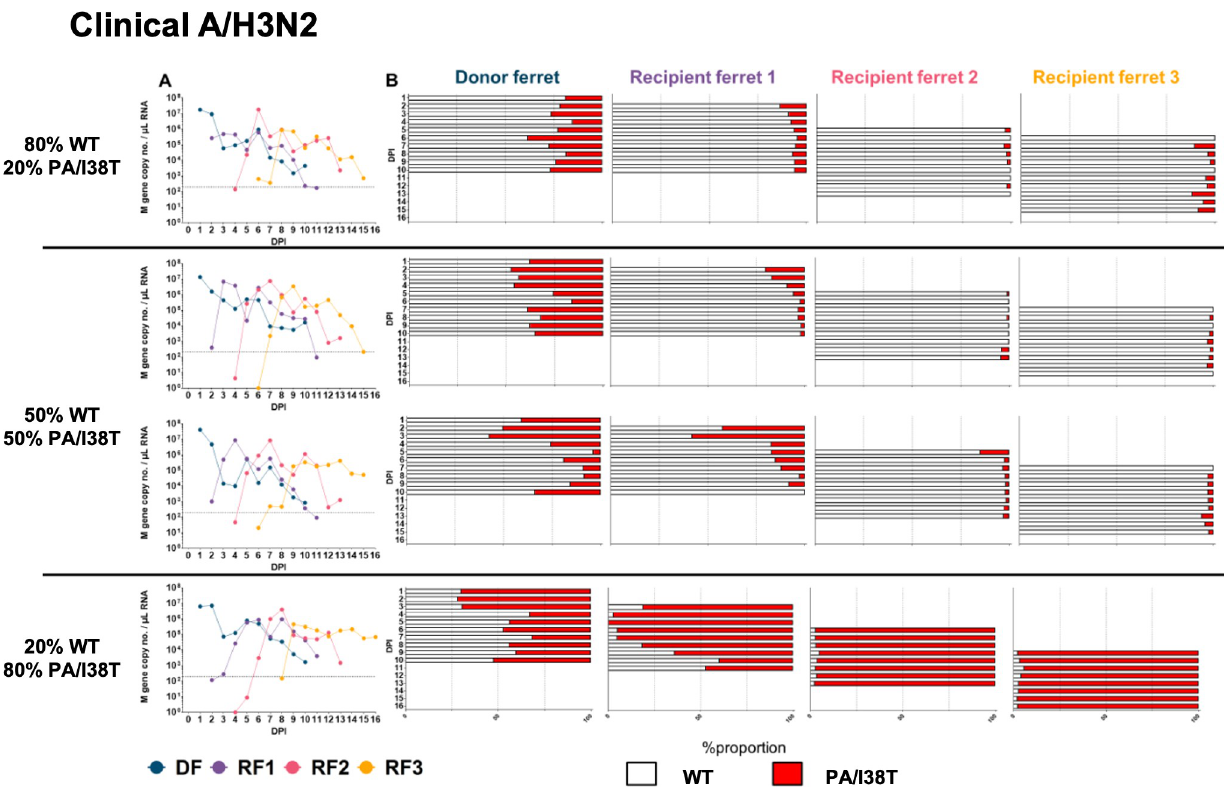
Fig 4. A) qPCR curves for A/H3N2 viral RNA and B) WT%:I38T% of viruses in ferret nasal washes. A/H3N2 DFs were infected (intranasal inoculation) with virus mixtures of WT and PA/I38T at a total infectious dose of 10 5 TCID 50 / 500 μ L. Daily nasal washes were collected from all animals for 10 consecutive days following inoculation/exposure, or until endpoint. RF1 was exposed to the DF by cohousing at 1 DPI. Na ï ve recipients were cohoused sequentially with the previous recipient (1:1) 1 day following detection of influenza A in RF nasal wash (Ct < 35). (A) Viral RNA was quantified